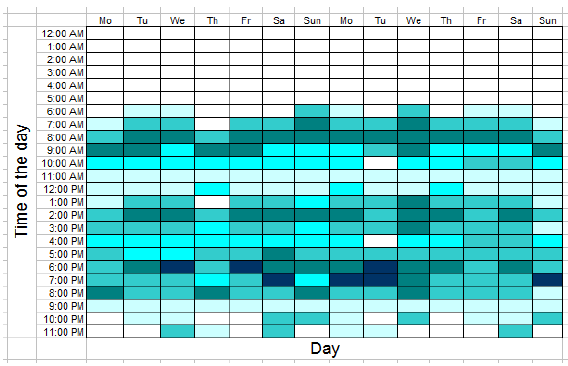
Figure 3. An example of color-coded activity density map.